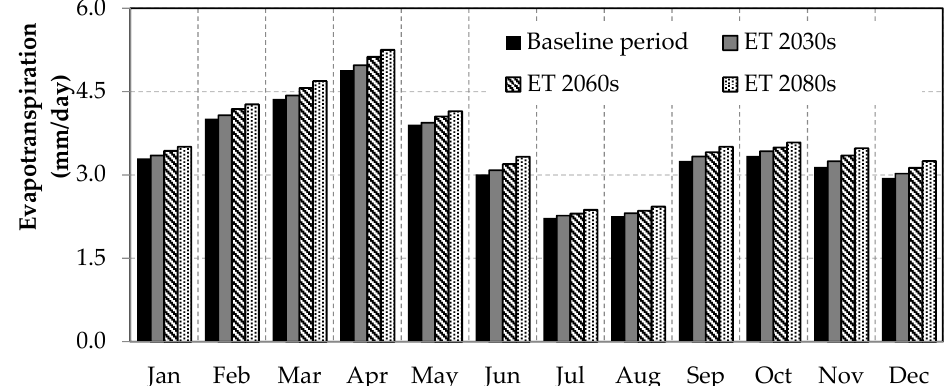
Figure 9. Long ‐ term mean monthly potential evapotranspiration for baseline period and future time horizons (2030s, 2060s, and 2080s) in the Main Beles and Gilgel Beles subbasins. The average annual projected rainfall was estimated to increase by 2.3% in the 2030s and expected to increase by 2.6% and 3.1% in the 2060s and 2080s, respectively. However, the monthly rainfall projection for the coming century did not show a consistent trend, unlike the temperature, which has indicated a consistent increasing trend throughout all time horizons (Figure 10). The projected rainfall showed a decreasing trend in May and June (months before the beginning of the major rainfall season) and an increasing trend was observed in September, October and November (i.e., the months after the major rainfall season) in the three ‐ time horizons. The major rainfall months (June and July) did not show a consistent trend. Therefore, this suggests that climate change may shift the rainfall pattern in the Main Beles and Gilgel Beles subbasins. Similar findings were captured by Abdo et al. [19], Dile et al. [20] and Adem et al. [39].